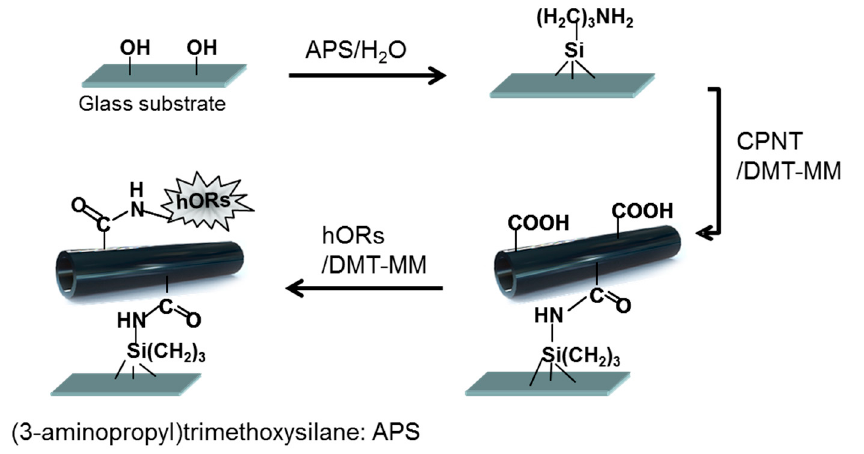
Figure 1. Fabrication process of the B-nose based on hOR-conjugated CPNTs. The hORs were immobilized on the surface of the CPNT by DMT-MM. CPNT: carboxylated PPy NTs; hORs: human olfactory receptors.